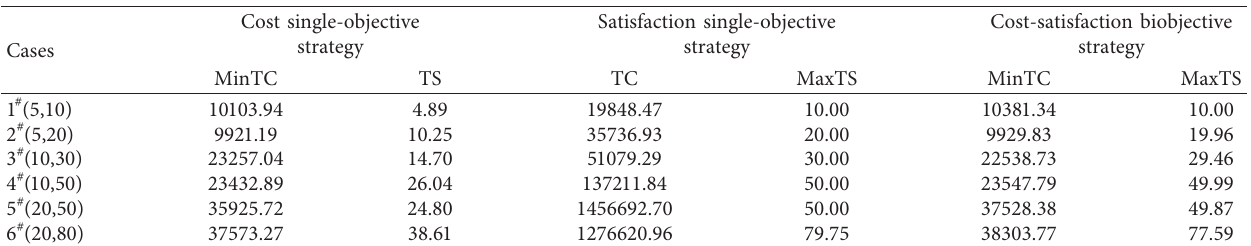
Table 3: Comparison test results between single-objective model and biobjective model weight l 1 � 0.5 and l 2 � 0.5